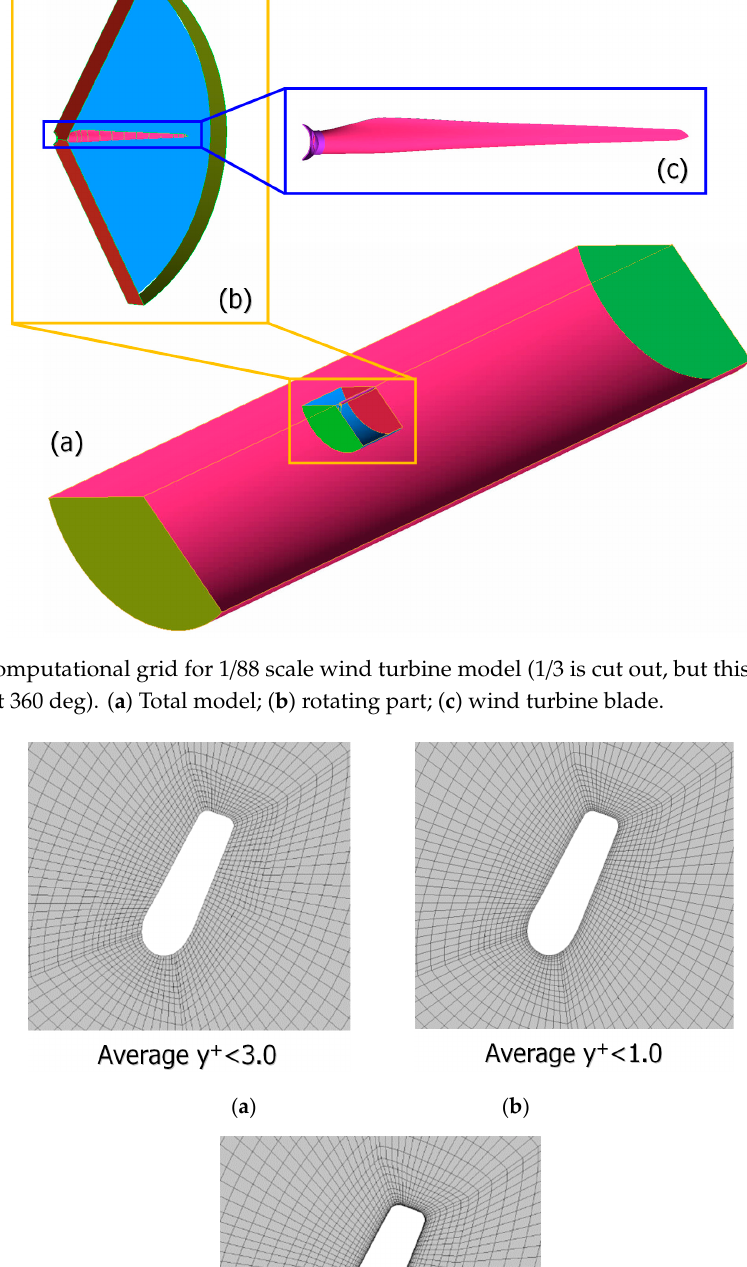
Figure 6. Computational domain and computational grid simulation of a wind tunnel experiment using a 1/88 scale wind turbine model, using the fully resolved geometries combined with large-eddy simulation (LES) simulations approach, produced by ANSYS(R) CFX(R).